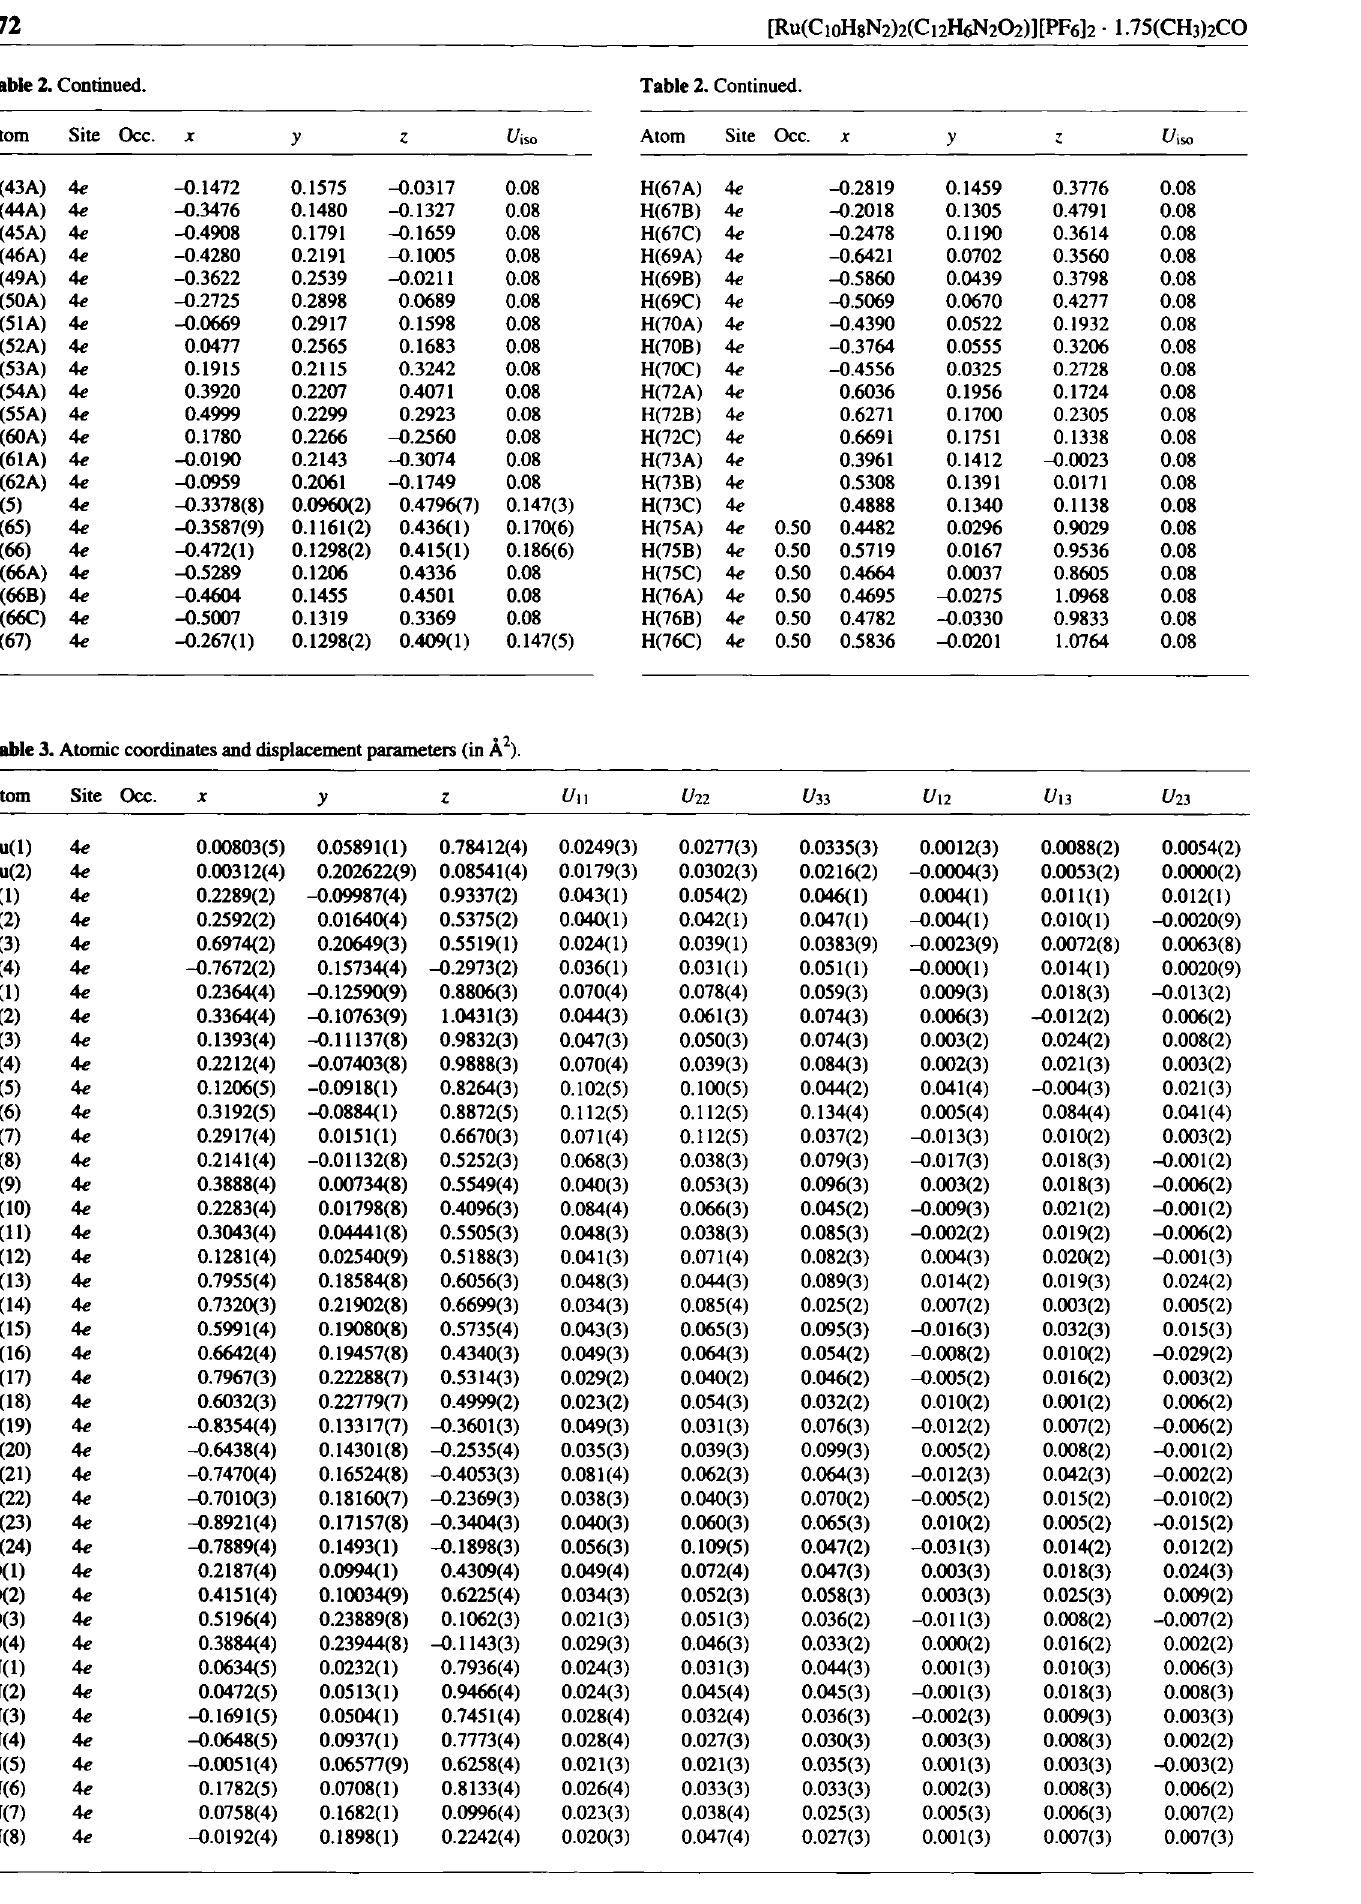
Table 3. Atomic coordinates and displacement parameters (in Â 2